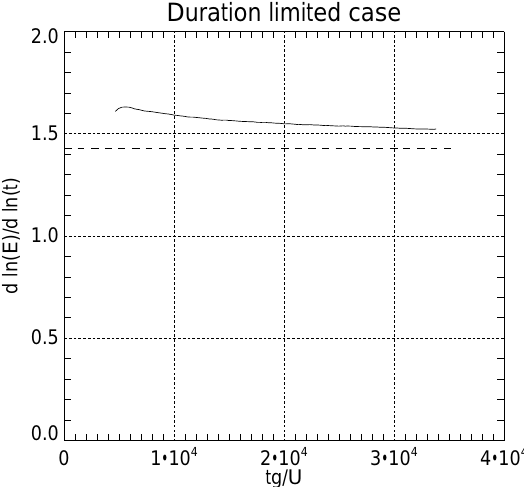
(cid:104) ω (cid:105) dln t